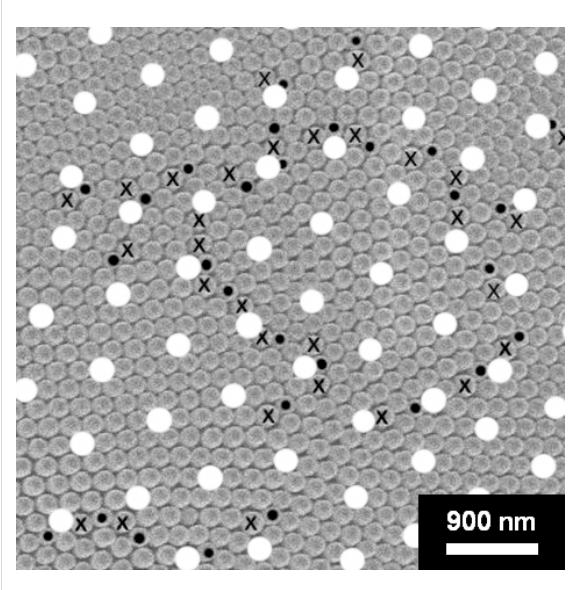
Figure 8: Several facets at very high tilt angle showing the curvature on each facet surface (magnification: 4,000×).